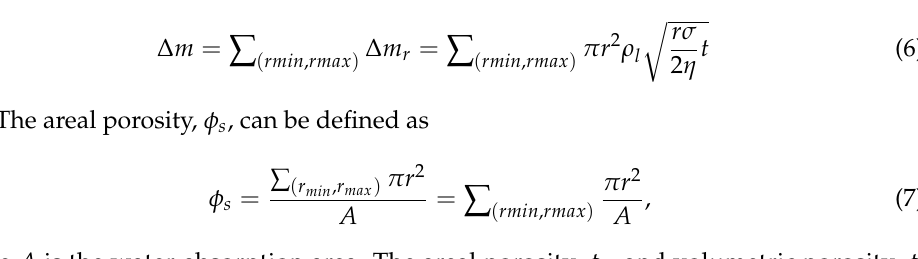
Figure 10. Sorptivities of damaged concrete specimens (w/c = 0.5) after different compressive stress levels.